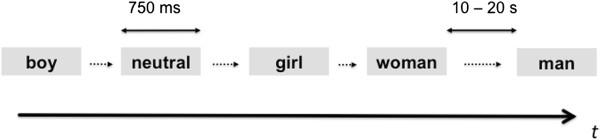
FMRI paradigm. We presented erotic pictures of adults (women/men) and children (girls/boys) interspersed with neutral control pictures. Pictures from each category were presented for 750 ms with a jittered interstimulus interval ranging from 10–20 s.